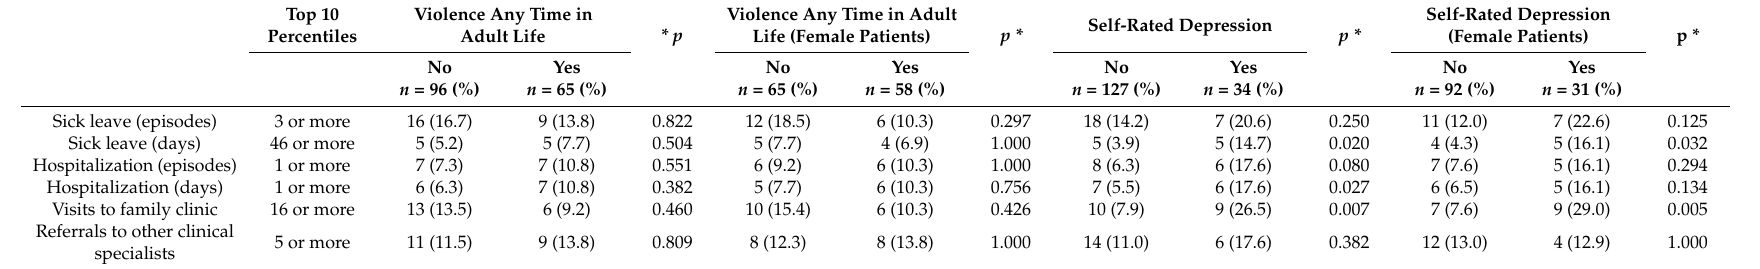
Table 1. The utilization of healthcare services concerning IPV exposure and self-rated depression in the last 12